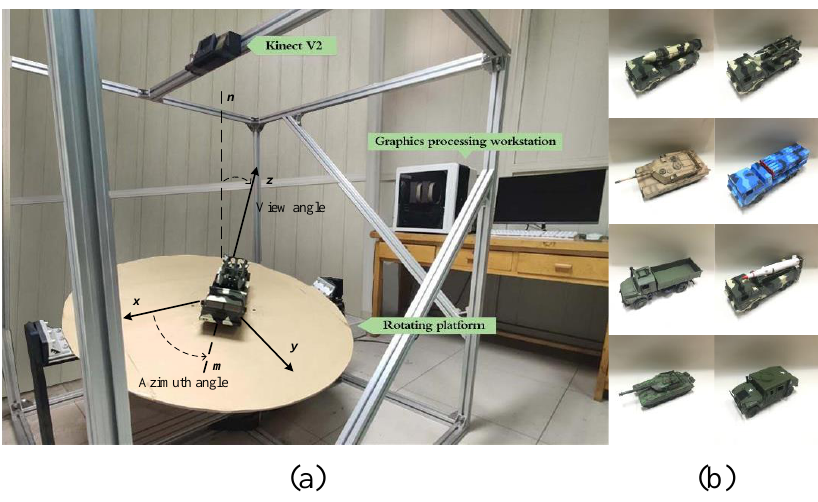
Figure 3. Experimental setup. ( a ) Image acquisition platform. ( b ) Target objects.